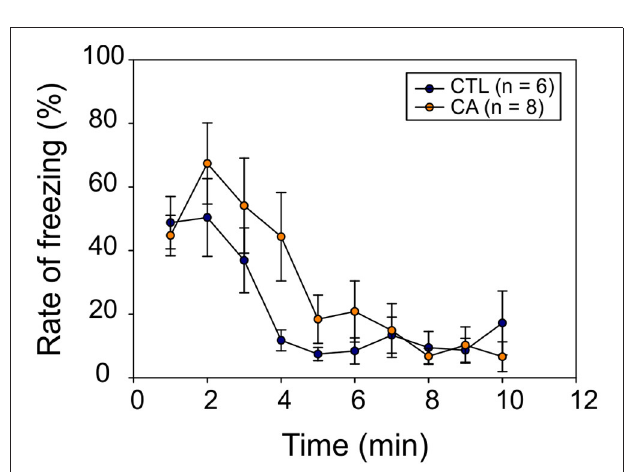
FIGURE 6 | Recall phase of the fear conditioning test. The graph represents the mean behavioral freezing rate (in %) over time obtained for 6 control (CTL, blue symbols) and 8 CA animals (orange symbols). Data are expressed as Mean ±